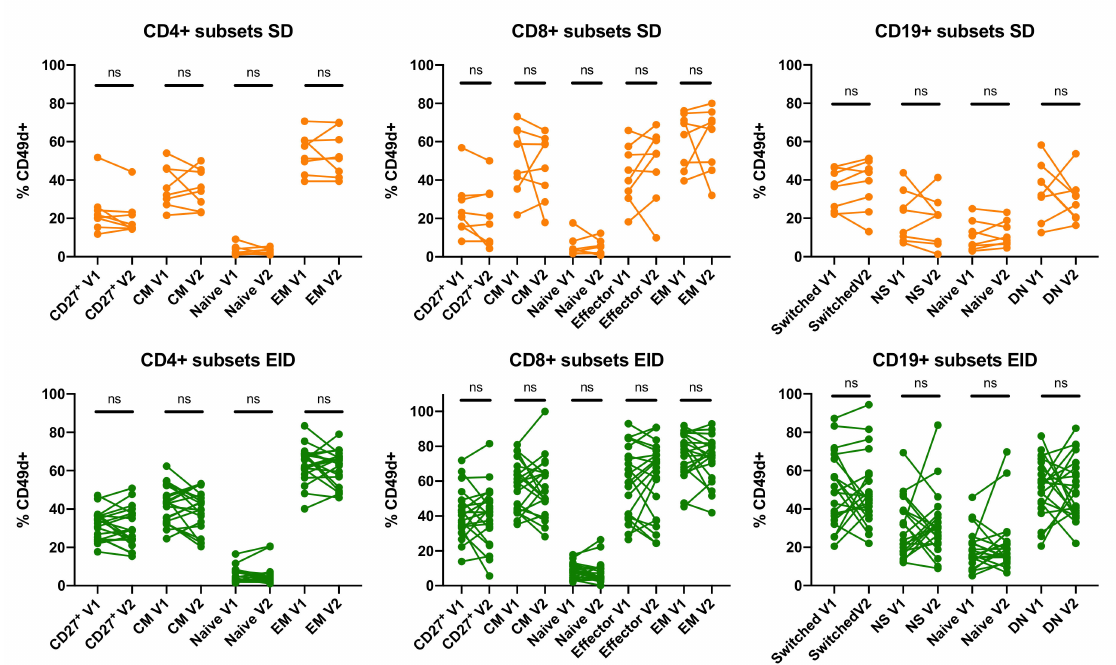
Figure 2. Comparison of first (V1) and second (V2) extractions within CD4 + and CD8 + T lymphocytes, and CD19 + B lymphocytes subpopulations in RRMS patients under Natalizumab treatment in SD or EID. Percentage of expression of in several CD4 + and CD8 + T lymphocytes, and CD19 + B lymphocytes subsets. Each dot represents the percentage of expression for each marker regarding their parent population (CD4 + or CD8 + T lymphocytes, or CD19 + B lymphocytes populations) in the SD ( n = 8) and EID ( n = 21) groups. CM, Central Memory; DN, Double Negative; EID, extended interval dosing; EM, Effector Memory; NS, Non-Switched; NTZ, natalizumab; SD, standard dosing. ns: p >